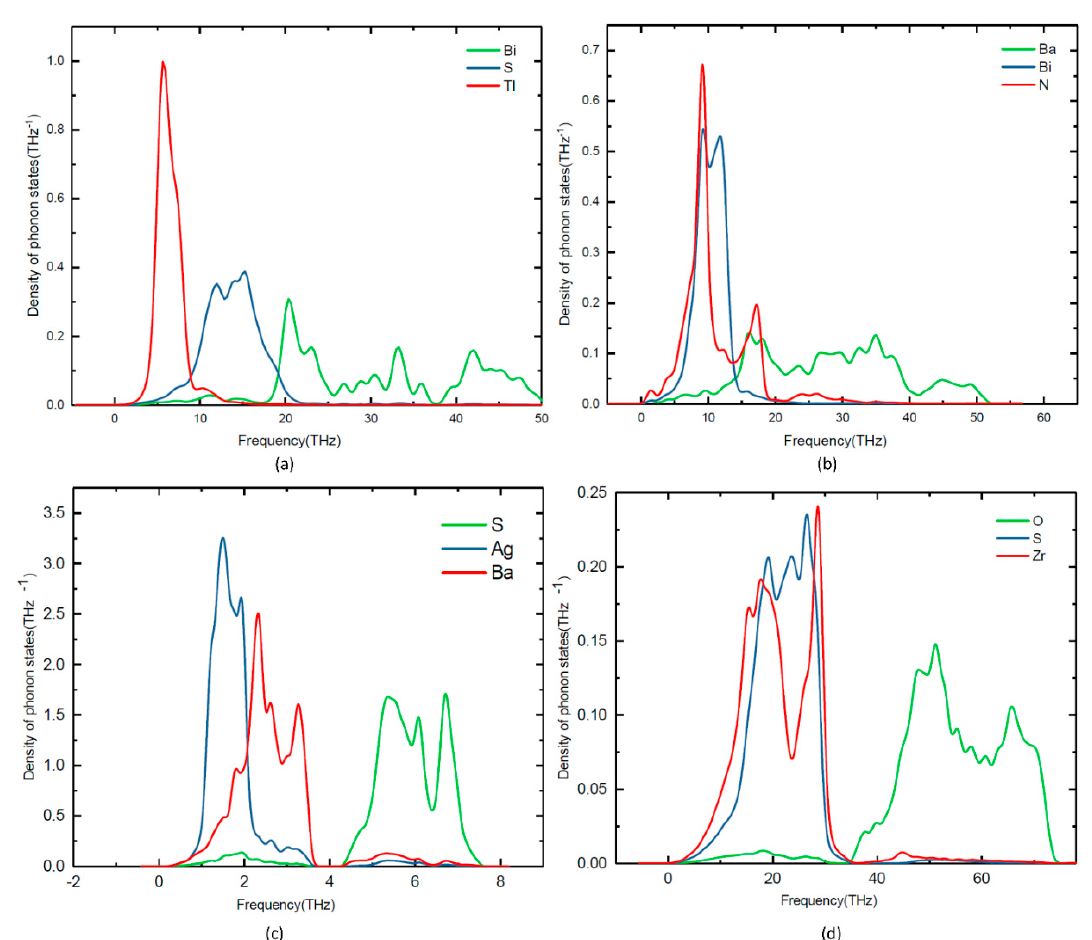
Figure 5. Calculated site projected phonon density of states for ( a ) TlBiS 2 , ( b ) Ba 3 BiN, ( c ) Ag 2 BaS 2 , ( d ) ZrSO.